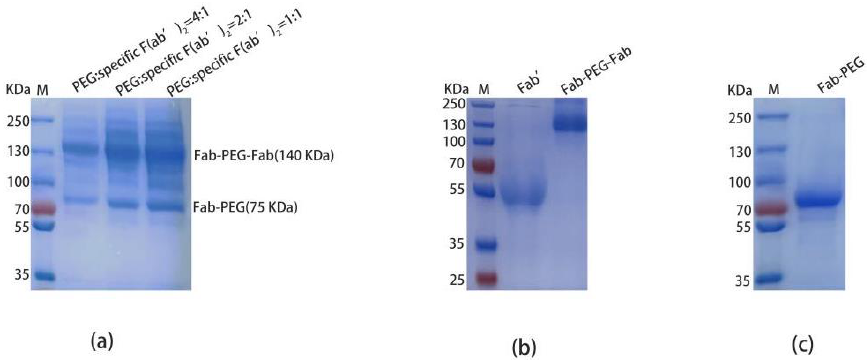
Figure 5. Non-reduced SDS-PAGE analysis of preparation and purification of PEGylated F(ab’) 2 . ( a ) The conditions of the specific F(ab’) 2 (10 mg) binding with the MAL-PEG-MAL. Protein standards (line M); MAL-PEG-MAL: specific F(ab’) 2 = 4:1 (lane 1); MAL-PEG-MAL: specific F(ab’) 2 = 2:1 (lane 2); MAL-PEG-MAL: specific F(ab’) 2 = 1:1 (lane 3). ( b ) The purification of the PEGylated F(ab’) 2 . Protein standards (line M); specific F(ab’) 2 reduced by TCEP (lane 1); Fab-PEG-Fab (10 mg) was purified by ion chromatography (lane 2). ( c ) Protein standards (line M); Fab-PEG (10 mg) was purified by ion chromatography (lane 1).